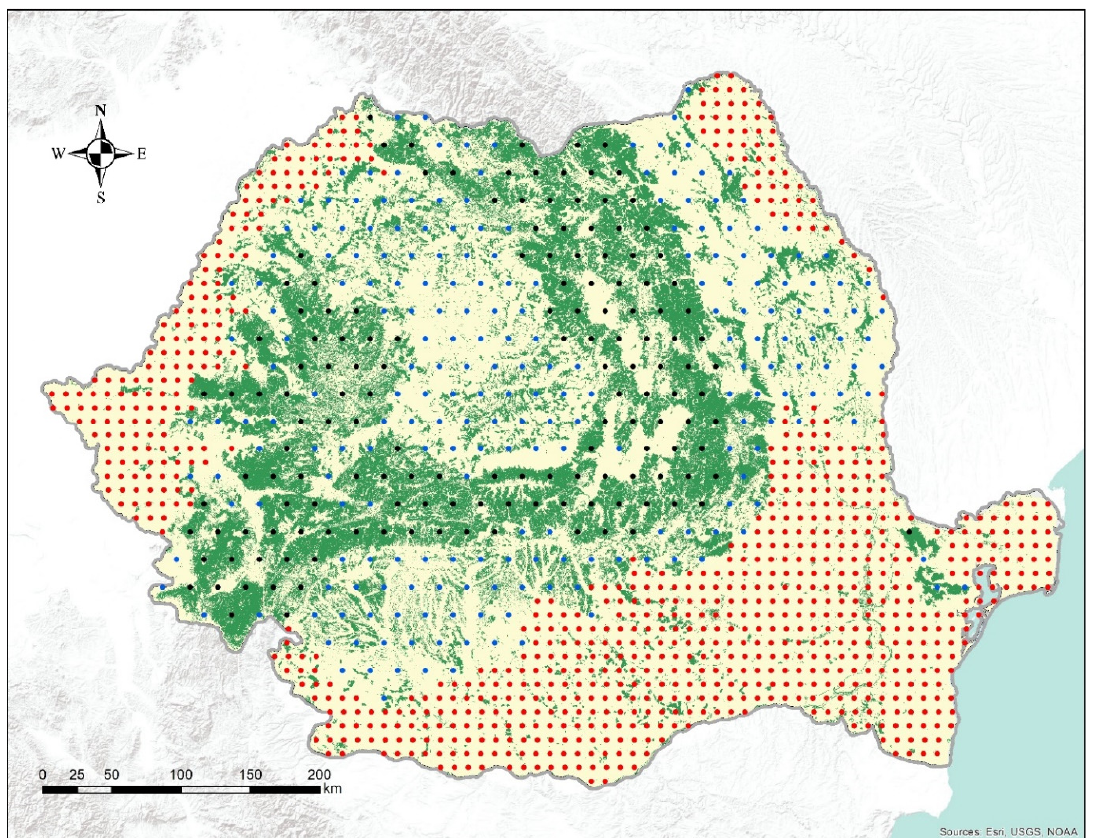
Figure 1. The PSC of the Romanian NFI overlaid on the general location of the forest, in green. The color of the PSC reflects the geomorphology: red for plains, blue for hills, and black for mountains. The spatial distribution of the PSCs does not reflect the actual density [12].